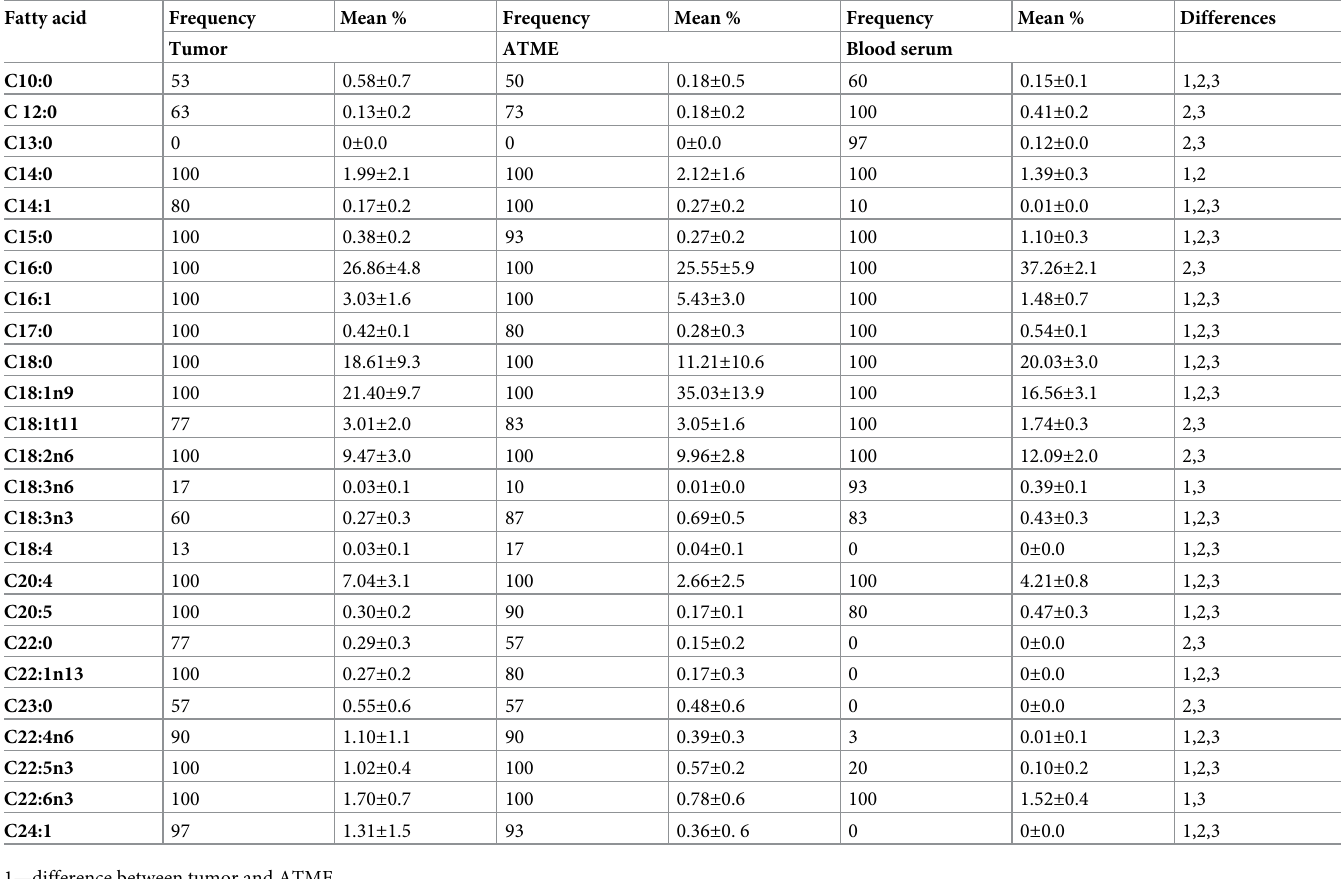
Table 2. Frequency of fatty acids (%) and percentage of fatty acids content (%) in tumor, ATME, and blood